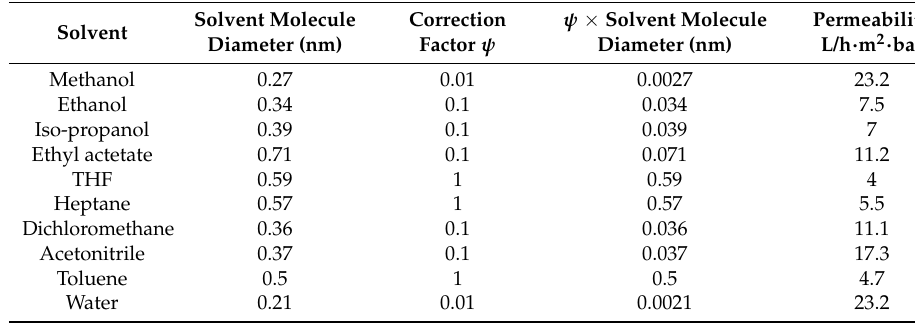
Figure 4. Solvent permeability versus 𝑟 solvent2 /𝜂 studied by [40].